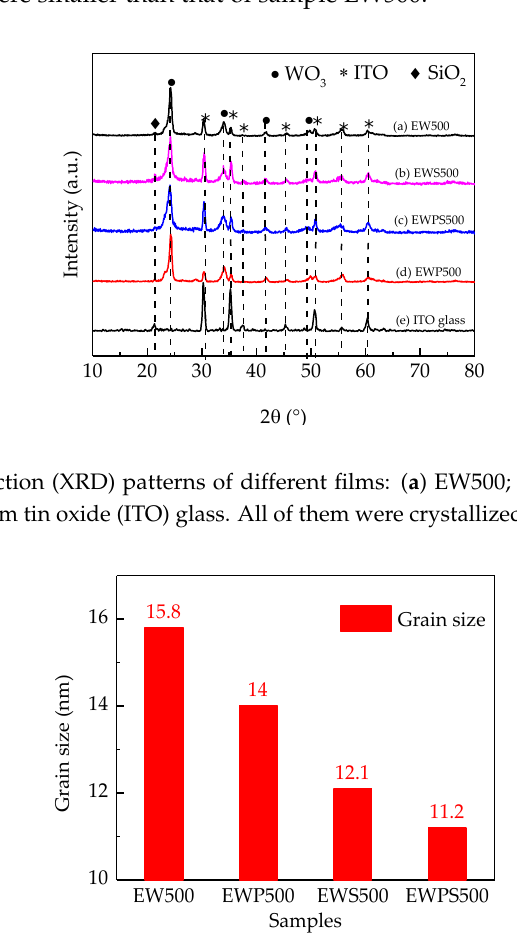
Figure 5. Crystalline grain sizes of different WO 3 films, calculated using the WO 3 main peaks (2θ ≈ 24.1°) in the XRD patterns.